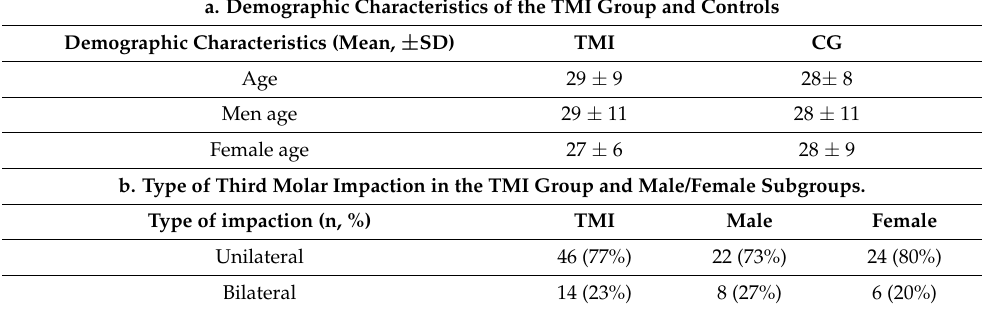
Table 1. a. Demographic characteristics of the Third Molar Impaction (TMI) group and controls b. Type of third molar impaction in the TMI group and male/female